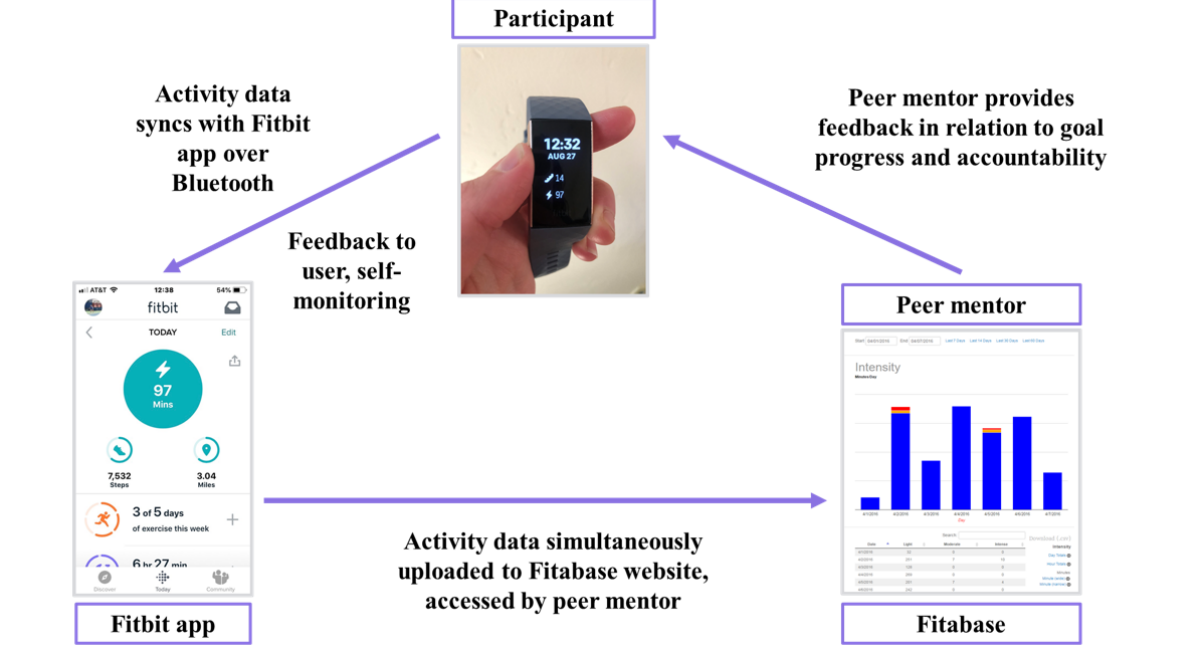
Figure 2. Visual depiction of how Fitbits will be used to support increasing physical activity in the Pink Body Spirit pilot